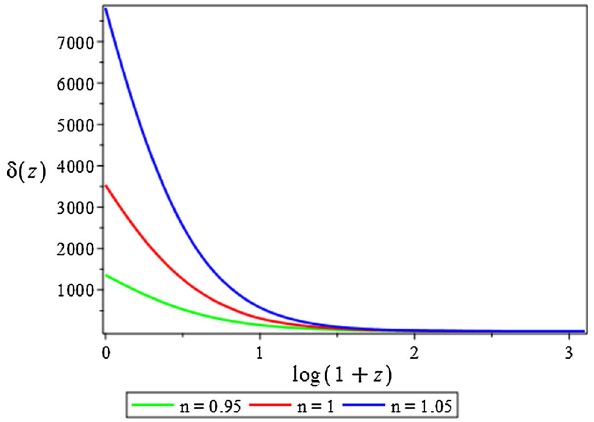
Fig. 16 δ( z ) versus z in long-wavelength mode for Eq. (115) for the values of n closer to one